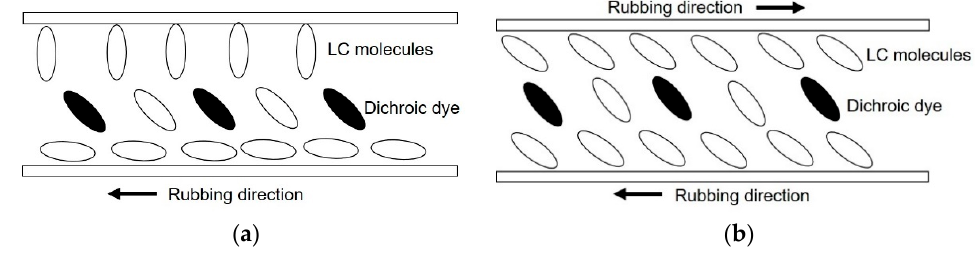
Figure 2. ( a ) Structure of HAN GH-LCDs; ( b ) Structure of high pretilt angle GH-LCDs.